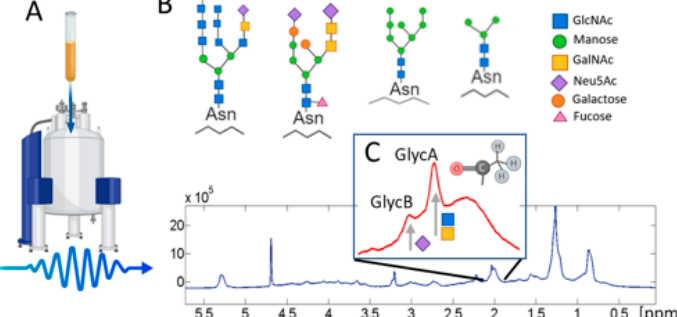
Figure 2. 1 H-NMR (nuclear magnetic resonance) glycoprotein analysis methodology. ( A ) Sample tube and spectrometer; ( B ) examples of N -glycans with different residues attached to the protein chain by asparagine (Asn); ( C ) 1 H-NMR spectrum produced by the sample in which the region of the glycoproteins is marked. The chemical group producing this signal is indicated.